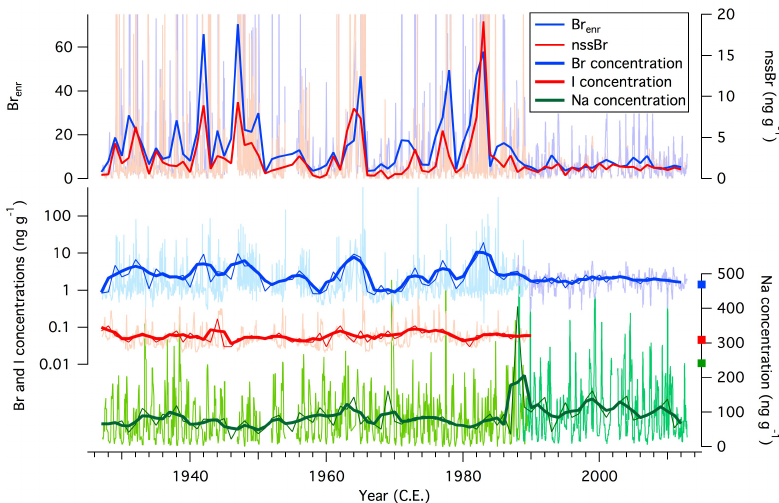
Figure 4. Time series of sodium, iodine and bromine concentrations as well as nssBr and Br enr at Law Dome. Raw data are shown in pale colours, with annual means shown by a thin line and 3-year running means shown by a thick line. For nssBr and Br enr , only raw data (pale colours) and annual averages (thick line) are shown. Different shades of blue and green are used to distinguish data from DSS0506 (1927–1989) and DSS1213 (1987–2013). The squares indicate average values from the DSS1516 snow